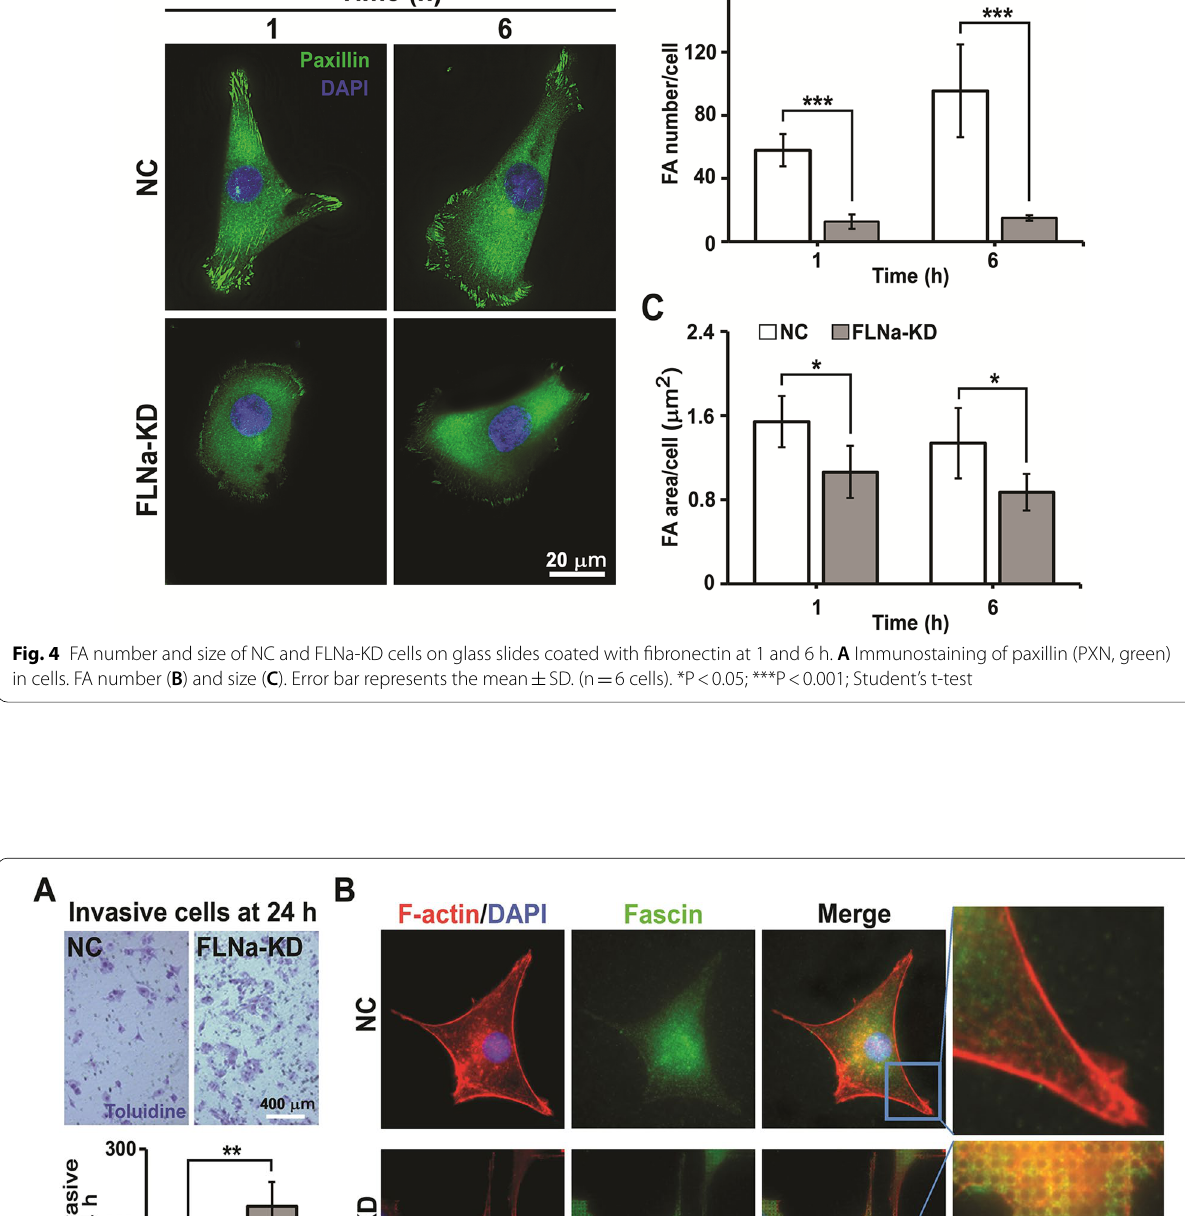
Fig. 5 Invasiveness and filopodia formation of NC and FLNa-KD cells. A Number of invasive cells obtained from 2 on the BioCoat ™ Matrigel ® Invasion Chamber for 24 h. Each experiment was repeated three times. Error bars represent the mean experiments. ** P < 0.01; Student’s t-test. B Images of filopodia extension in cells with fluorescent staining of F-actin (RP: red), nuclei (DAPI: blue), and immunofluorescent staining of the actin bundling protein fascin